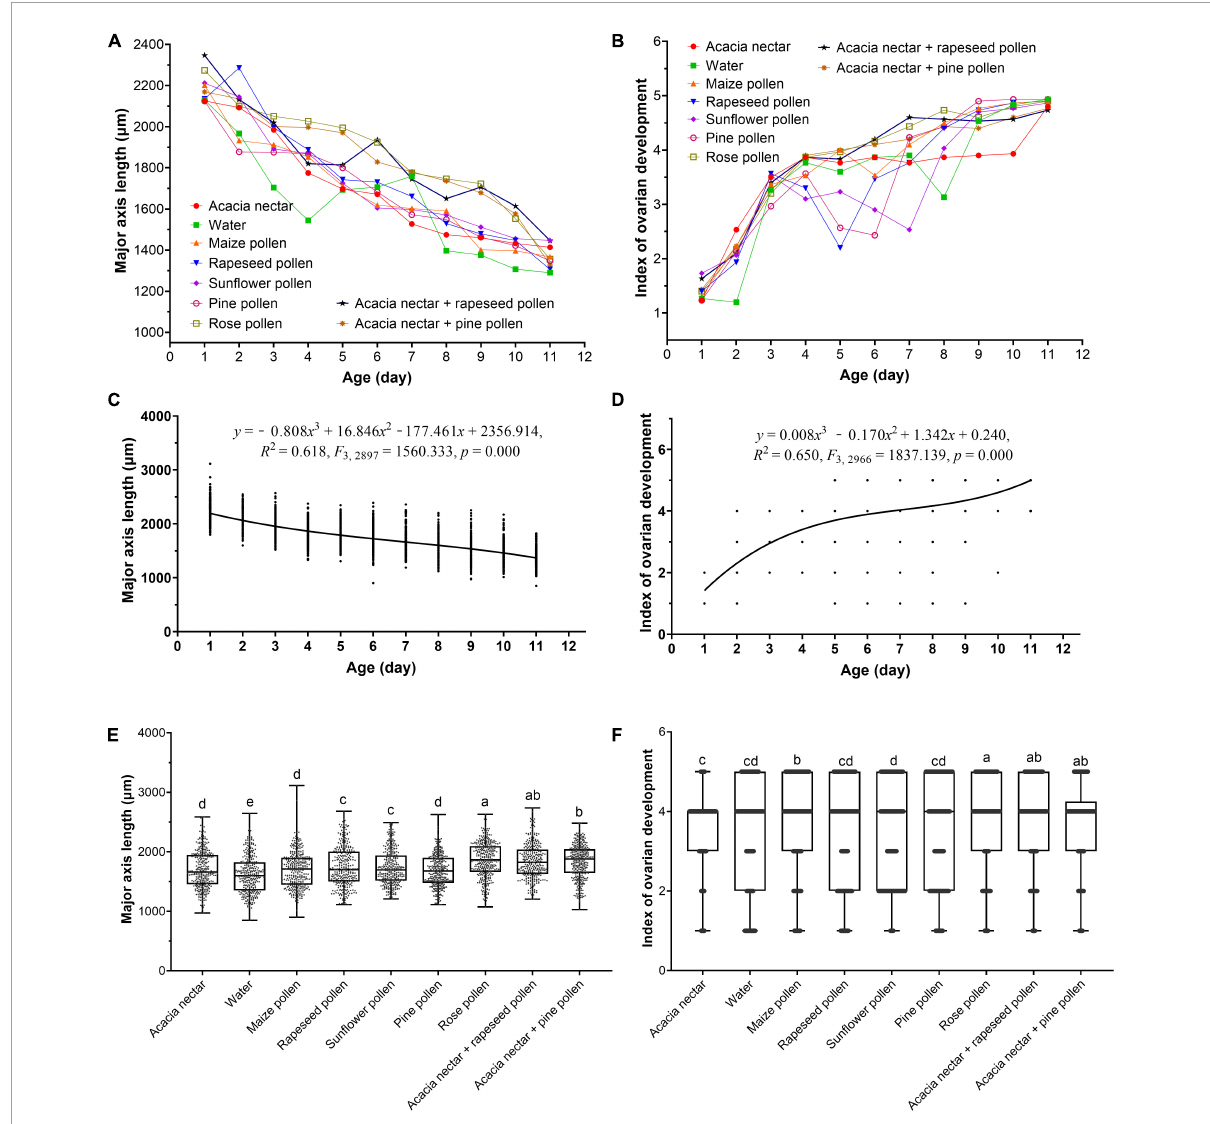
FIGURE6 Effect of age and diet on testis size (A,C,E) and ovarian development level (B,D,F) of Mythimna loreyi . In (C,D) , means ± SE are showen. In (E,F) , the bottom and top of the black box indicate the first and third quartile values, respectively; the horizontal solid line shows the median for each category; bars indicate the maximum and minimum. Different lowercase letters above the bar indicates a significant difference (two-way ANOVA, Duncan’s MRT; p <